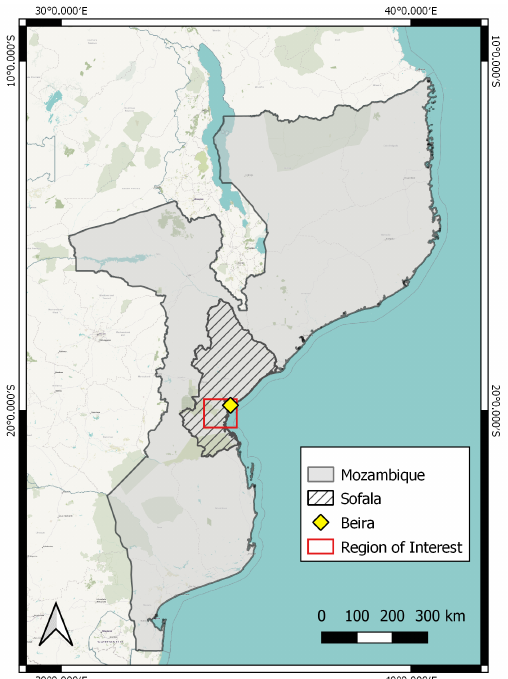
Figure 1. Case I: ROI near the city Beira in the Province of Sofala, Mozambique (Spatial reference system EPSG:4326 [14])